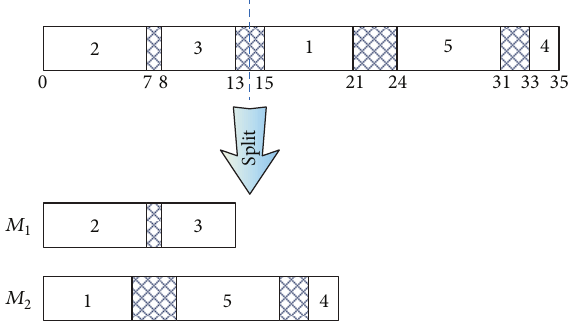
Figure 1: Splitting of the original job sequence in the cases 𝛼 1 = 1.0 and 𝛼 2 = 1.5